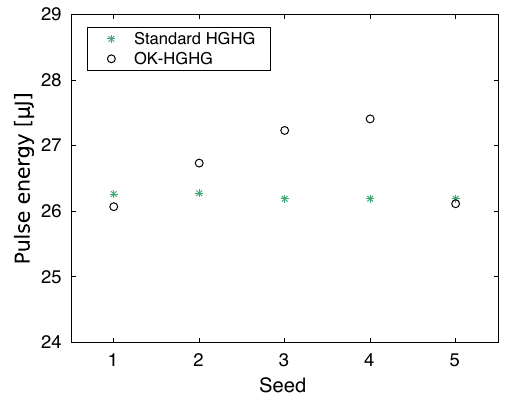
FIG. 10. Shot-to-shot fluctuations of pulse energy for the standard HGHG and the OK-HGHG